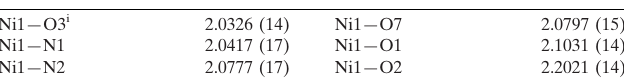
Selected bond lengths (A˚ ).